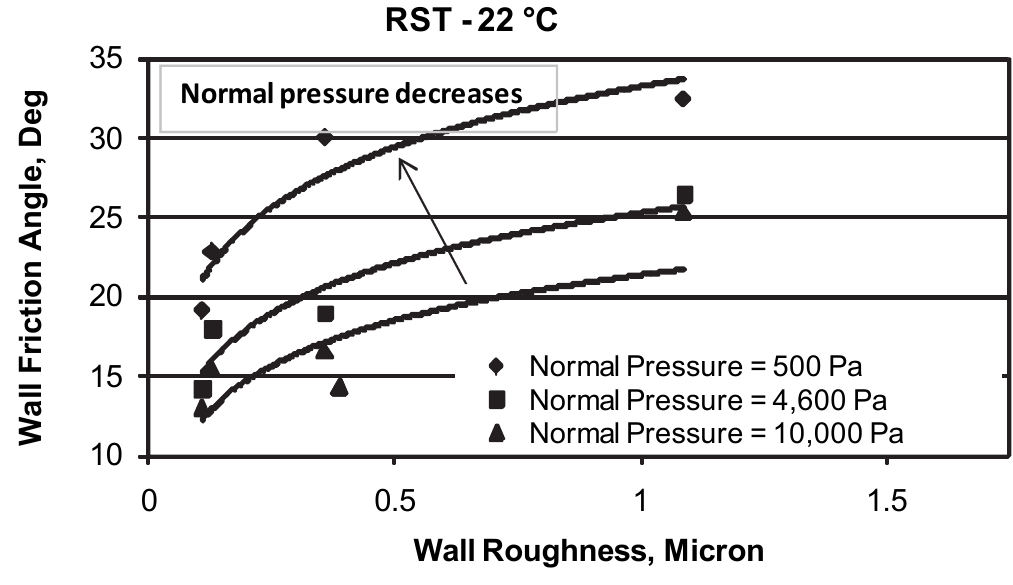
Fig. 5 Wall Friction Angle vs. Wall Roughness (RST at 22 ℃ ).